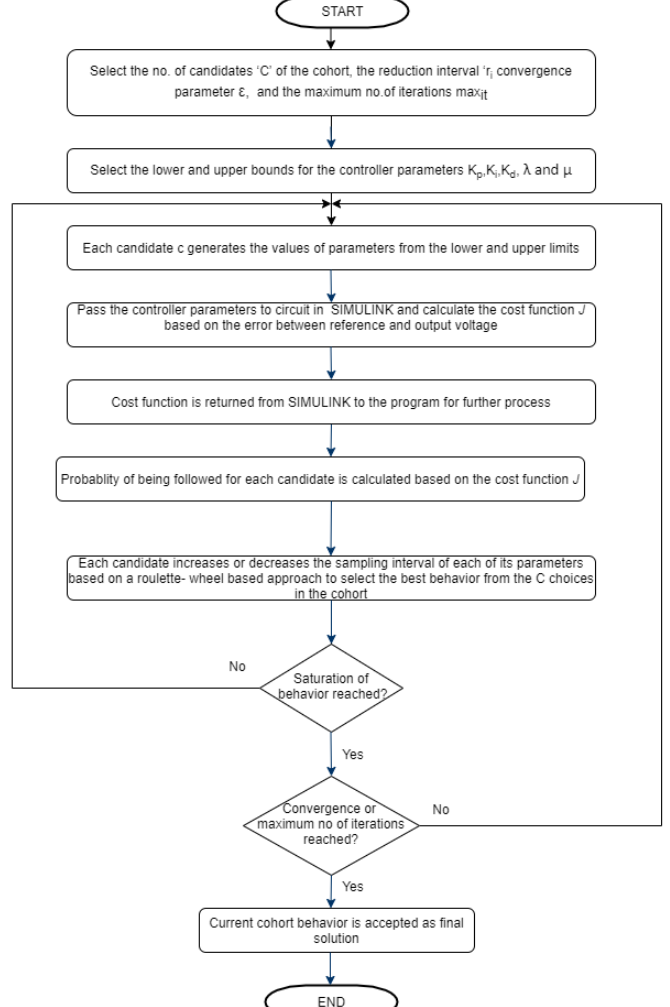
Figure 4. CI Flowchart used for Buck converter